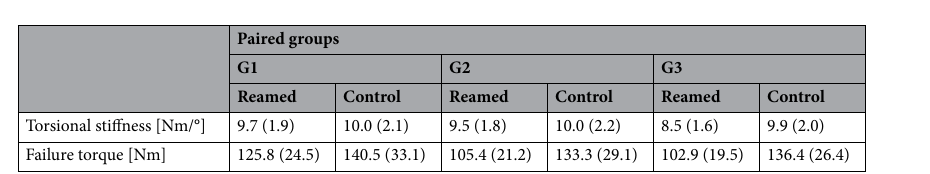
Table 5. Results of the biomechanical testing presented in terms of mean values and standard deviation according to Schmitz et al. 12 .